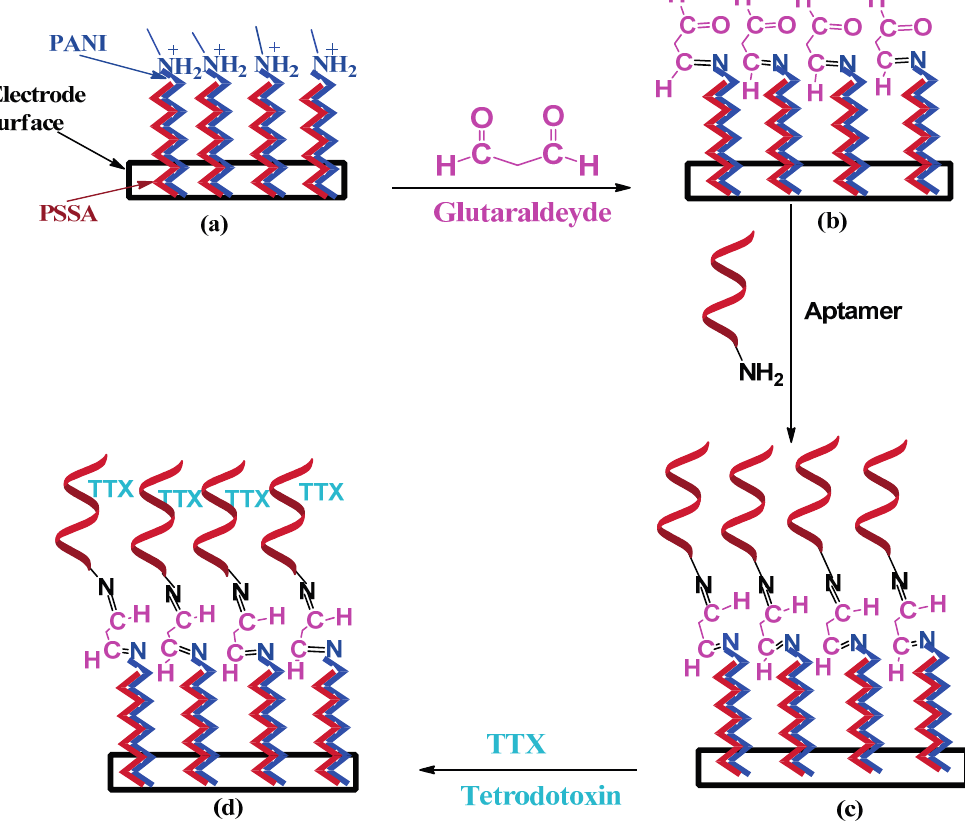
Figure 1. Schematics for the development of the TTX aptasensor: ( a ) electrodeposition of PSSA-doped polyaniline onto the carbon electrode; ( b ) glutaraldehyde-functionalization of PANI/PSSA film; ( c ) immobilization of NH 2 -aptamer on glu-PANI/PSSA/GC; and ( d ) TTX